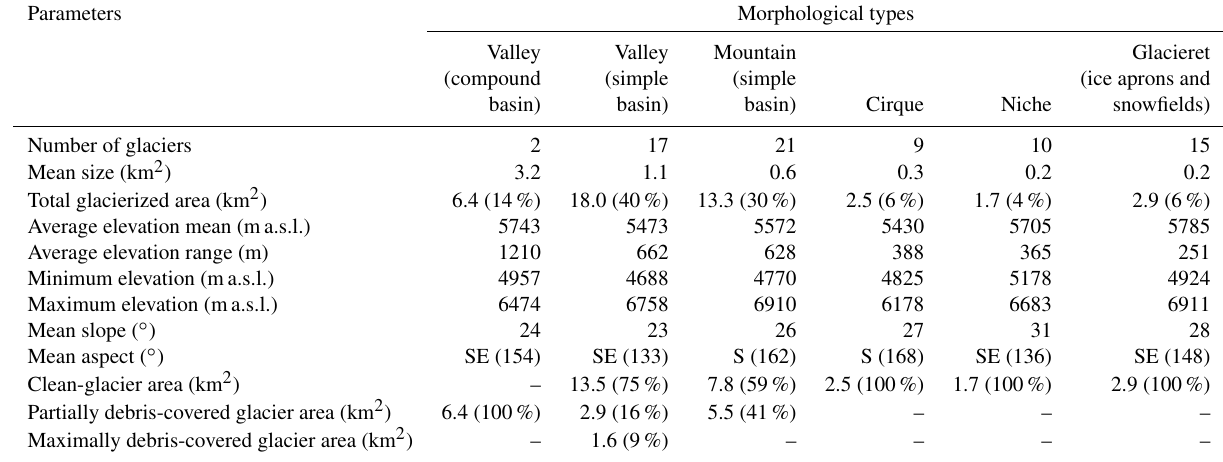
Table 3. Glacier parameters according to morphological types (2018) for the Chhombo Chhu Watershed based on Sentinel-2A and the SRTM DEM.